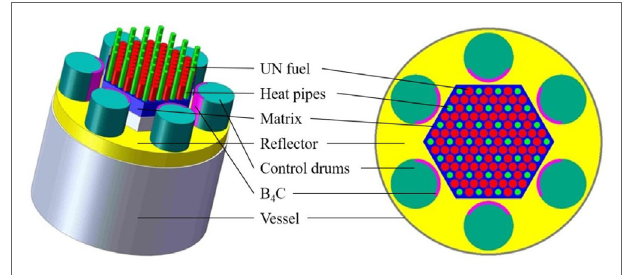
FigUre 2 | Structure of heat pipe cooled reactor core.